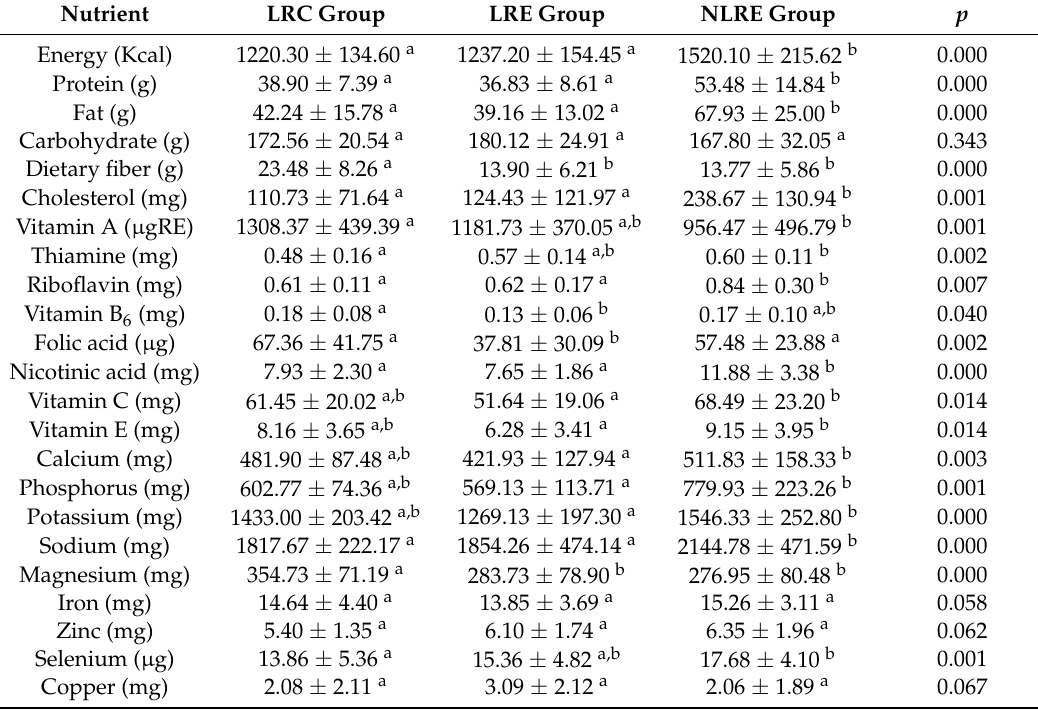
Table 2. Nutrient intakes in the LRC group, LRE group and NLRE group 1